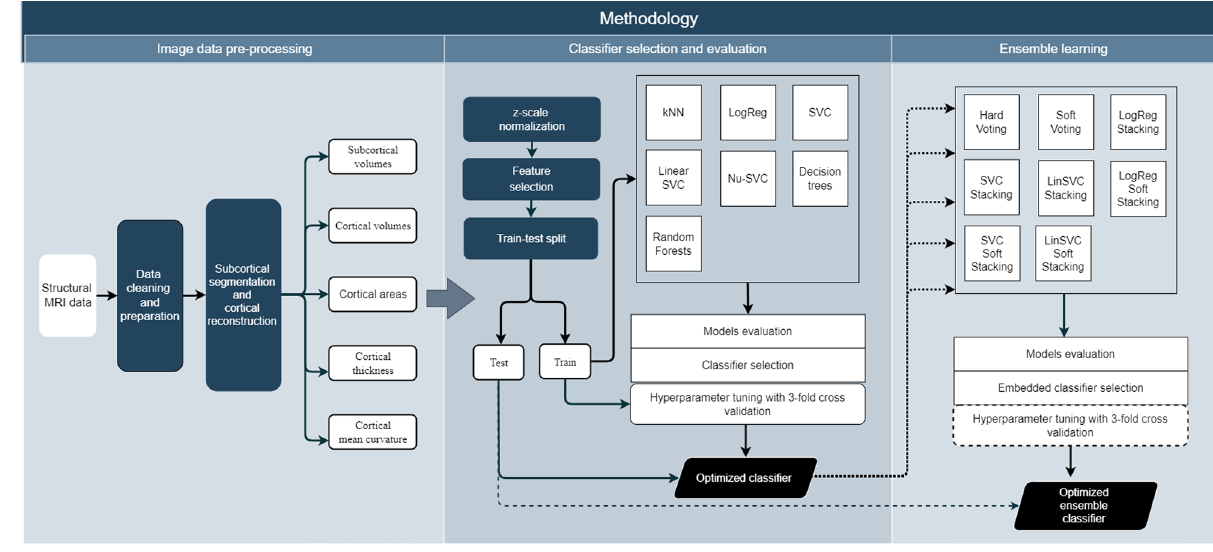
Figure 2. Overview of classification